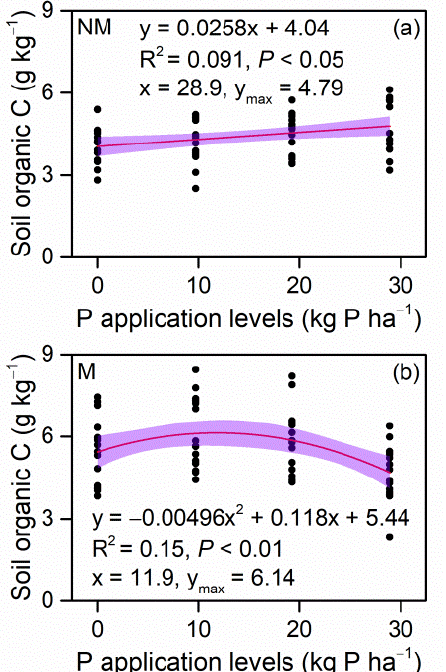
Figure 2. Relationship between soil organic C (SOC) and P application level (P0, P1, P2, and P3) under no film mulching (NM, a ) and film mulching (M, b ). There were three replicates. The solid red lines are fitted lines; the corresponding 95% confidence bands are shaded purple (the reader is referred to the web version of this article to interpret the color references in the figure legend).